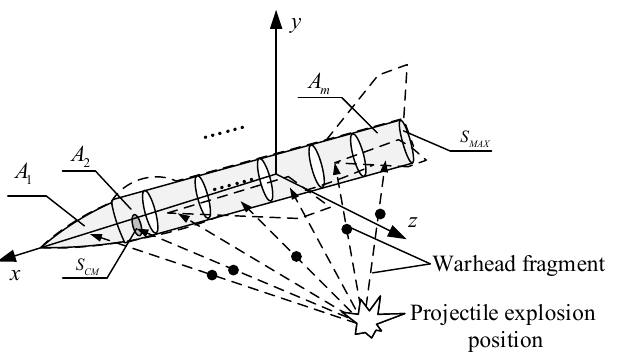
Figure 2. The schematic diagram of the multi-components of the aircraft target. The damage gain for the whole aircraft target is superimposed by the damage gain of m equal unit cabin compartments. Then, the damage gain for the whole aircraft target can be obtained by Formula